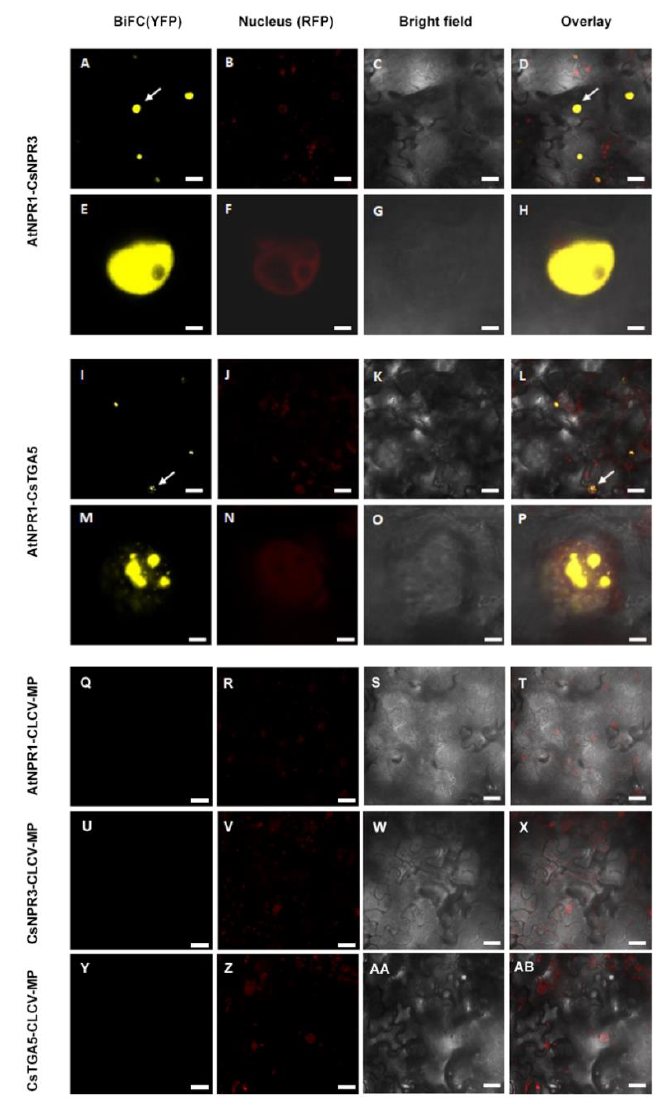
Figure 7. Confocal micrographs showing results of bimolecular fluorescence complementation assays (BiFC) assays to determine interactions between AtNPR1 with CsNPR3 and CsTGA5 proteins. ( A –AB) show micrographs of YFP (BiFC), nuclear marker (Nucleus), transmission white light (Bright field) and the resultant overlay, respectively. The upper set of panels are showing positive interaction and the bottom set of pictures are showing the negative controls. ( A – H ) show the AtNPR1 and CsNPR3 positive interaction. ( E – H ) is a zoom up containing nuclei details. In ( I – P ) the positive interaction between AtNPR1 and CsTGA5 is demonstrated and ( M – P ) is a zoom up showing nuclei. White arrows indicate nuclear interaction. ( Q – AB ) pictures show the negative controls. All the constructs were transiently co-expressed in Nicotiana benthamiana RFP-H-2B plants. The scale bars represent 35 µ M in length and for the magnified images each bar represent 5 µ M in length.